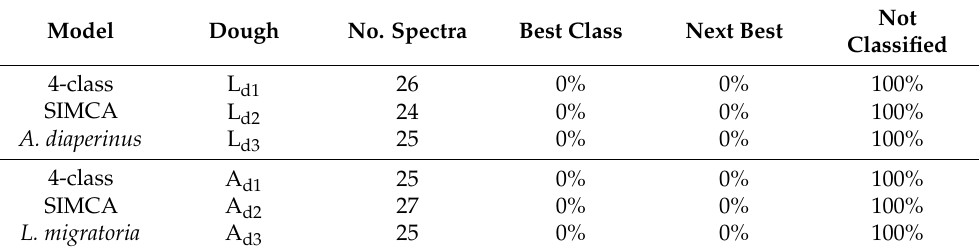
Table 5. Dough model predictions of A. diaperinus SIMCA model using L. migratoria spectra and L. migratoria SIMCA model using A. diaperinus